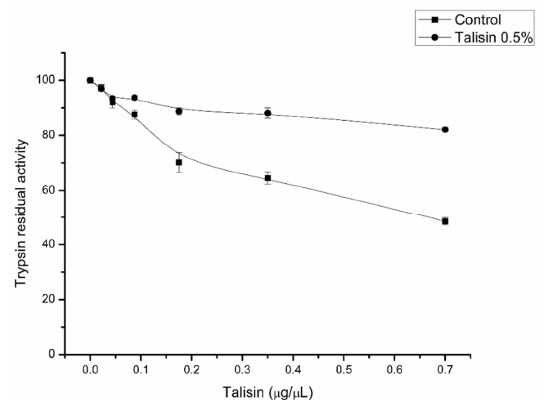
Figure 3. In vitro inhibition of proteolytic activity of midgut trypsins of Spodoptera frugiperda larvae fed on control diet (square) and diet containing 0.5% talisin (circle), using the synthetic BApNA substrate.